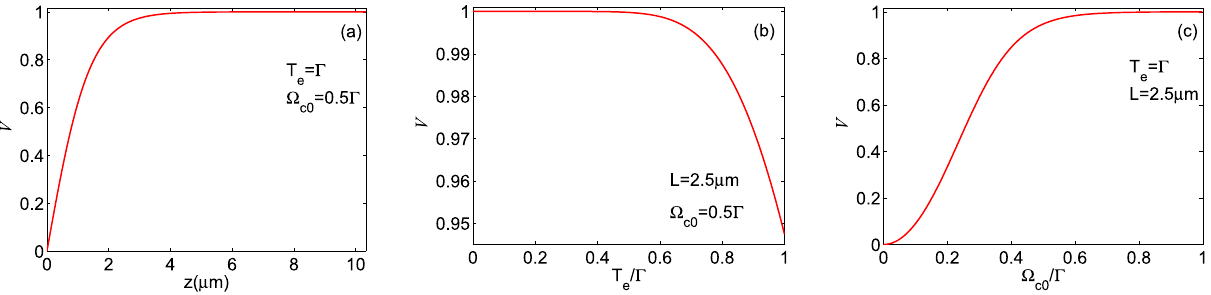
Figure 6. The visibility of the induced periodic waveform as a function of ( a ) medium length (for T e = Ŵ and � c 0 = 0.5 Ŵ ), ( b ) tunneling parameter (for L = 2.5 µ m and � c 0 = 0.5 Ŵ ), and ( c ) strength of the coupling field (for T e = Ŵ and L = 2.5 µ m).